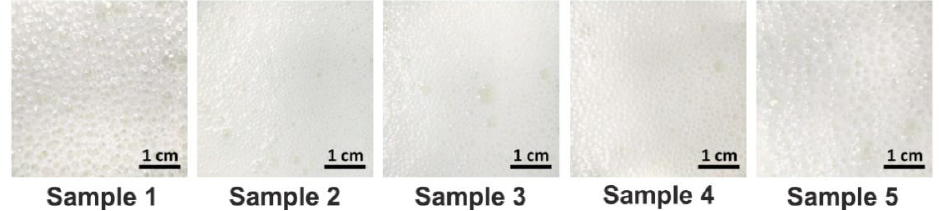
Figure 2. The bubble size and bubble homogeneity of WPH–PS compositions. The in vitro assessment of antioxidant and antihypertensive properties of the prod- samples to scavenge peroxyl radical (ORAC). The potential antihypertensive